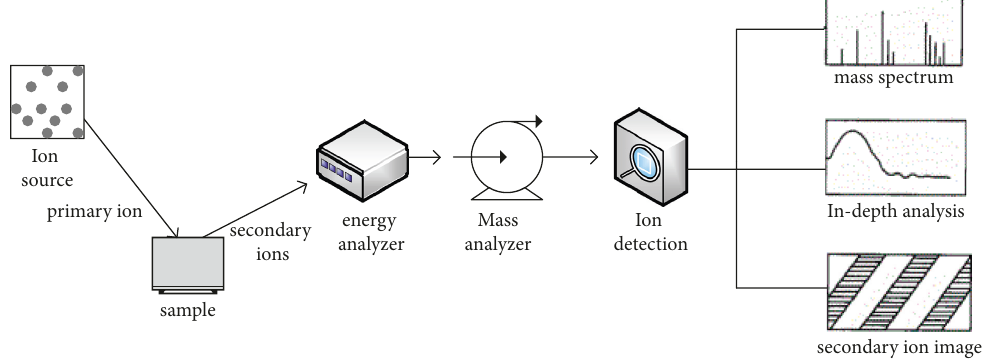
Figure 3: Principles of secondary ion mass